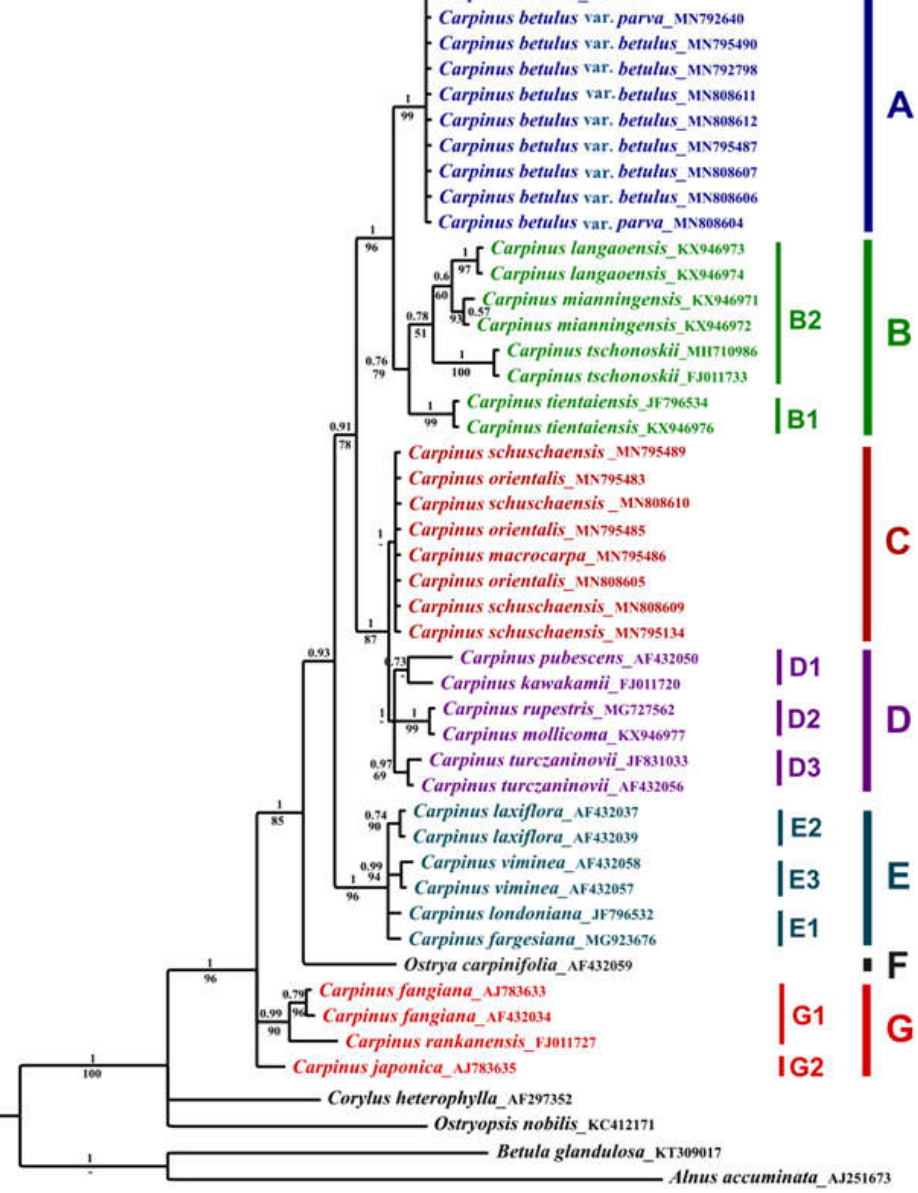
Fig. 4. Tree result of merging Bayesian and maximum likelihood trees by analyzing the ITS data. Numbers above the branches are posterior probabilities (PP) values of Bayesian inference (BI), and numbers below the branches are values of maximum likelihood